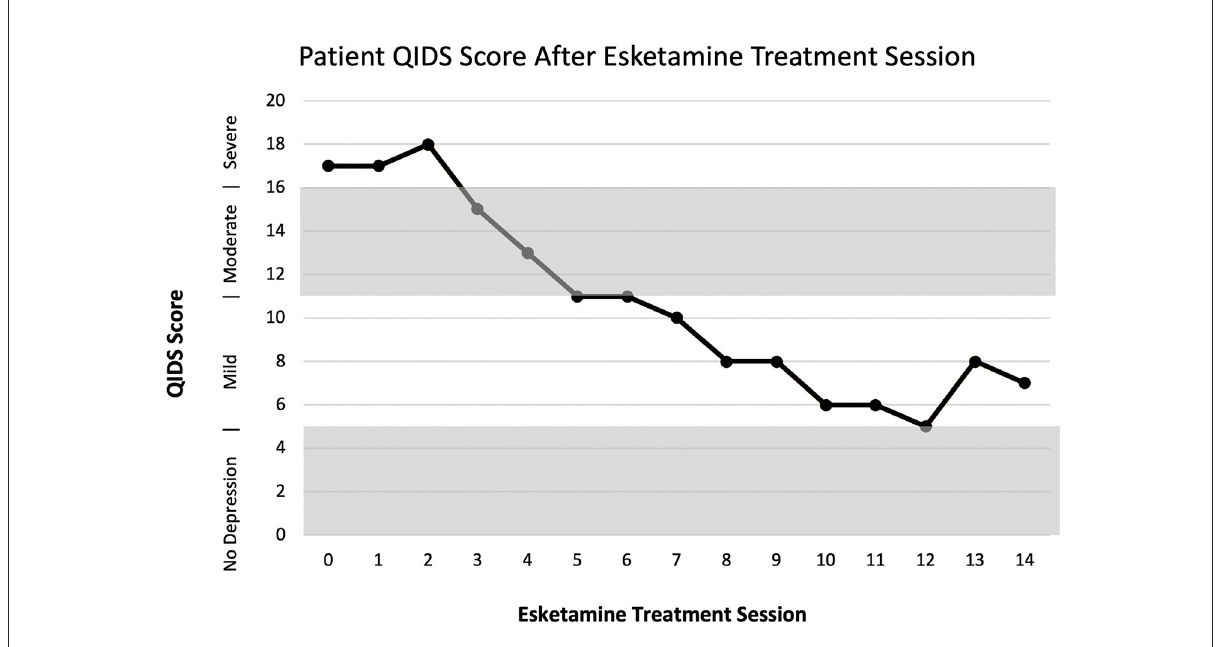
FIGURE1 Patient QIDS score after treatment with